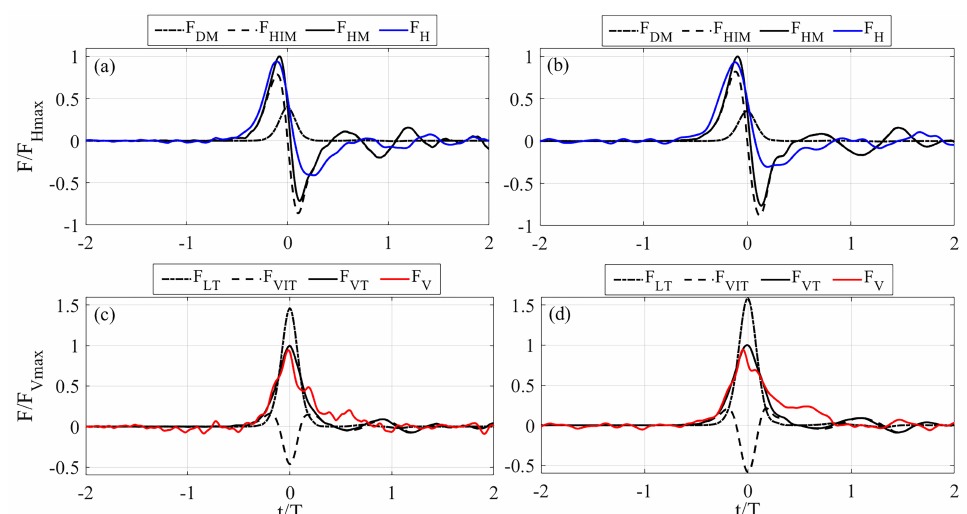
Figure 12. Experimental and calculated time series of hydrodynamic forces. ( a ) Comparison between experimental F H and Morison F DM , F HIM and F HM (test no. 8); ( b ) comparison between experimental F H and Morison F DM , F HIM and F HM (test no. 18); ( c ) comparison between experimental F V and transverse F LT , F VIT and F VT (test no. 8); ( d ) comparison between experimental F V and transverse F LT , F VIT and F VT (test no.